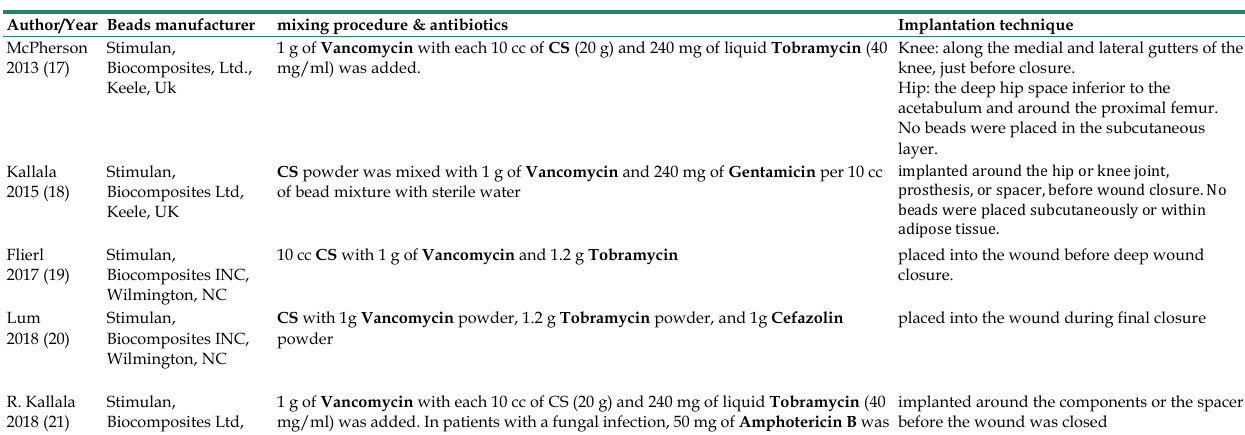
Table 3. The antibiotic